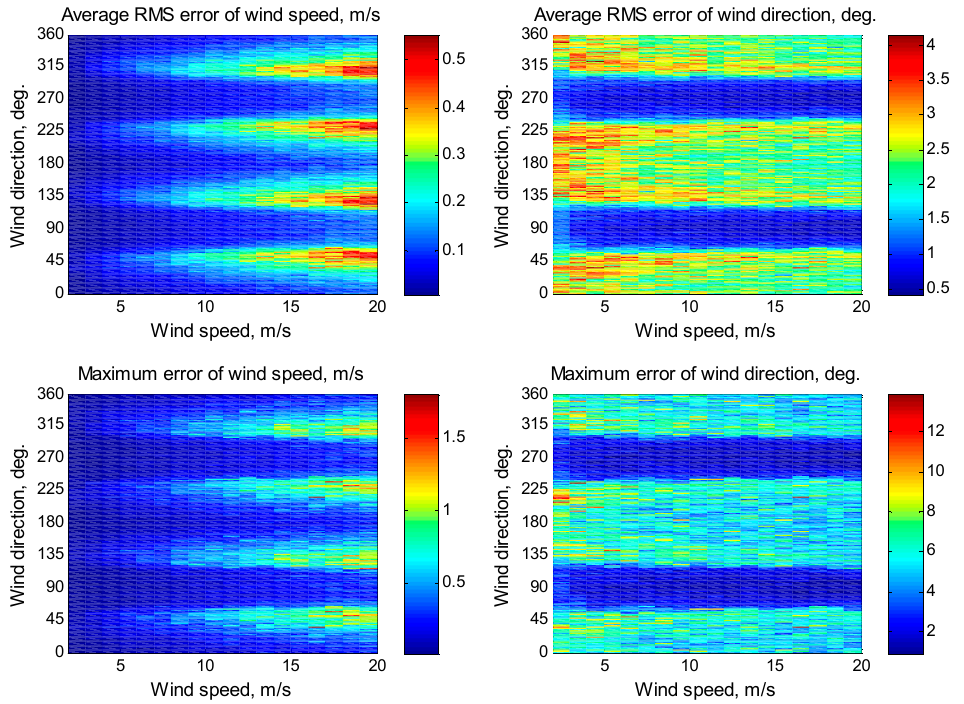
averaged NRCS samples for each azimuthal angle.